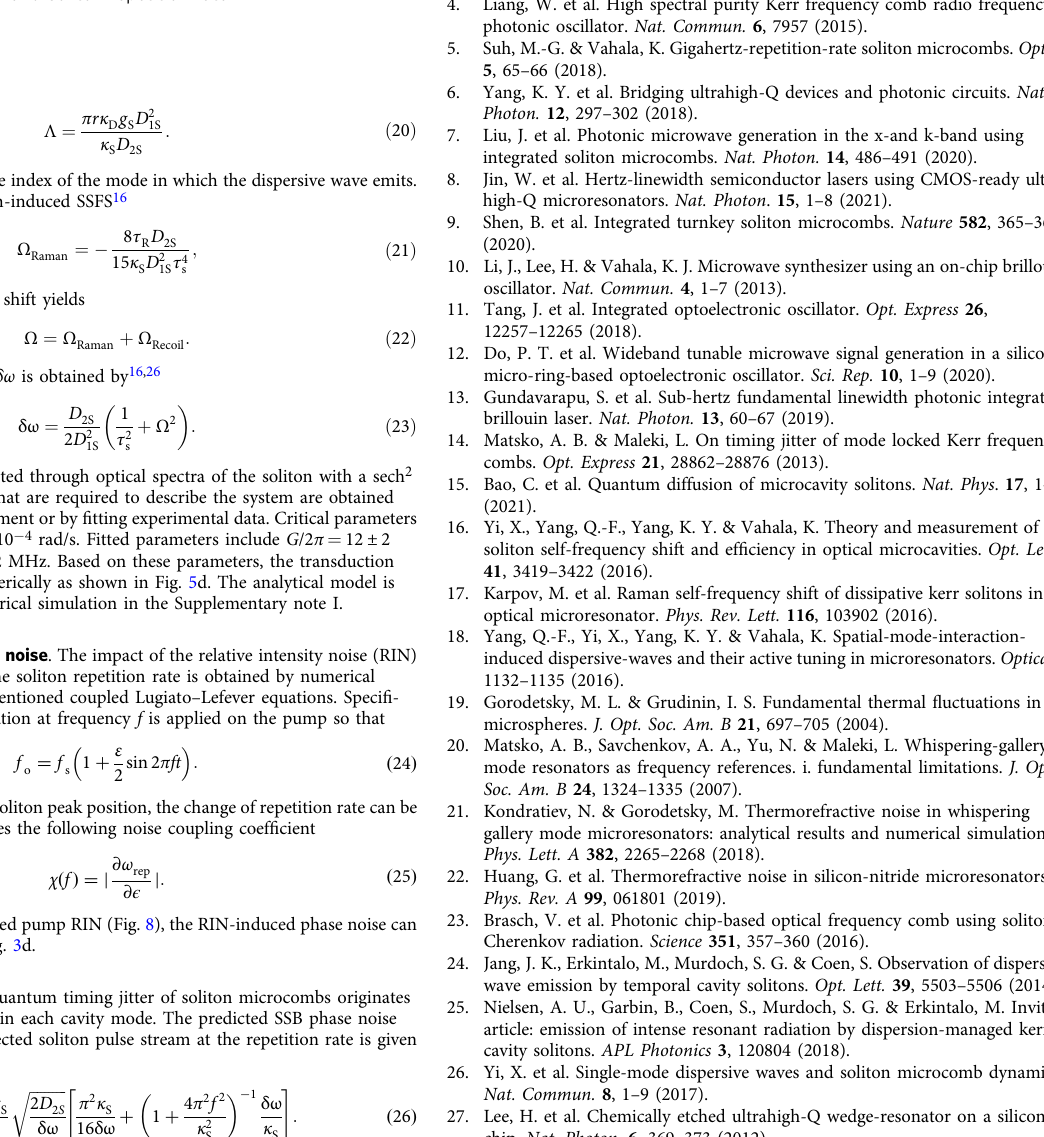
Fig. 8 In fl uence of pump laser relative intensity noise (RIN). a Measured SSB RIN of the pump laser. b Simulated noise transduction factor χ ( f ) between pump laser RIN and soliton